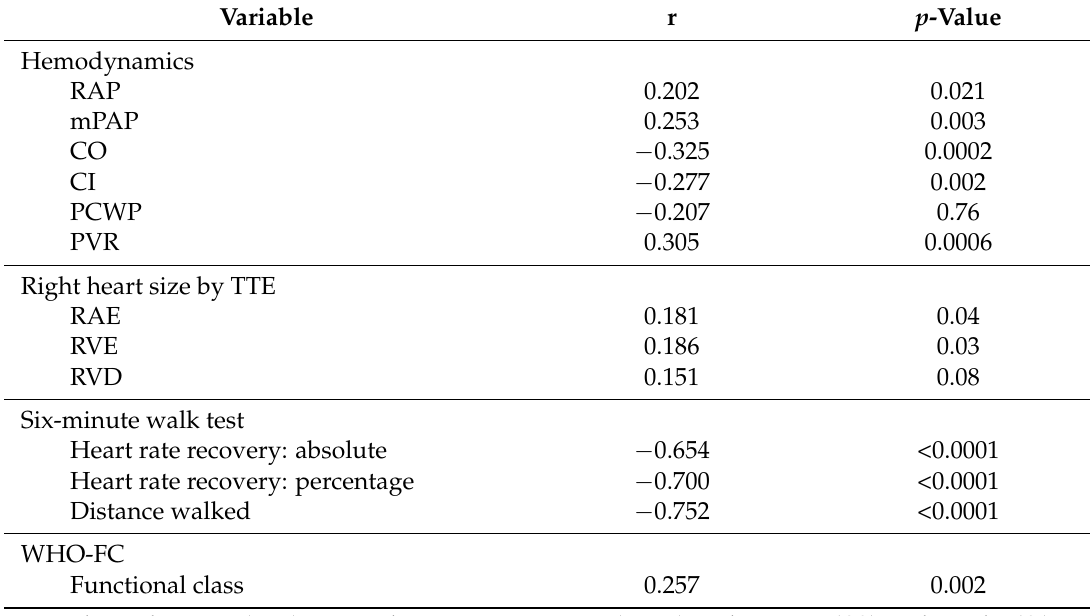
Table 2. Correlation coefficients between brain natriuretic peptide and all variables.